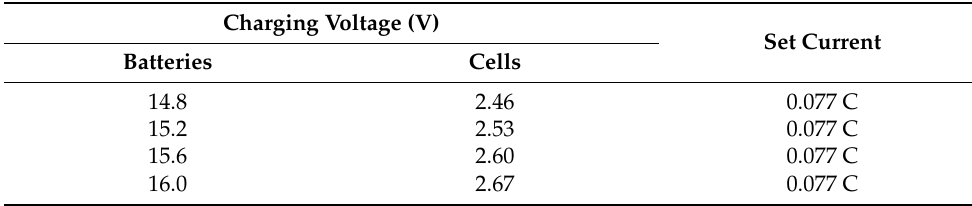
Table 1. Charging voltages and currents set in the experiments.